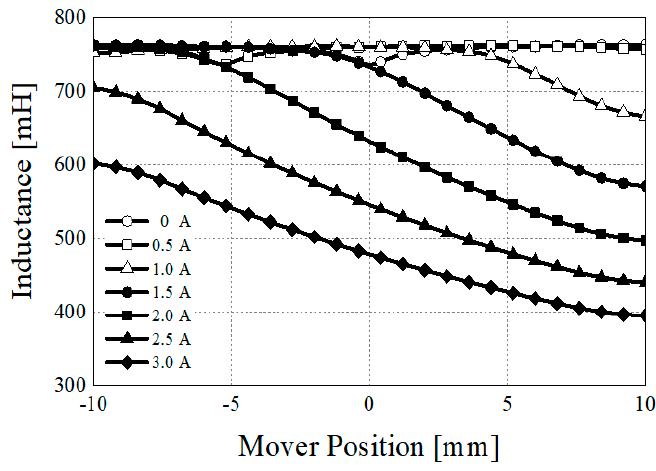
Figure 4. Inductance of LOM according to mover position and input current.